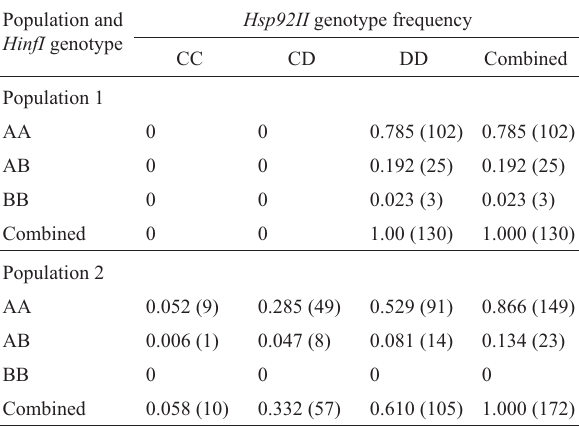
Table 1 - Genotypic frequency distributions for the MYF 5 gene HinfI and Hsp92II polymorphic loci haplotypes for two pig populations. The num- berofpigswithrecordsforeachgenotypefrequencyisshowninparenthe- ses. Population 1 (n = 130), composed of 28 Yorkshire, 46 Landrace, 21 Yorkshire¡ x Landrace and 35 Landrace x Yorkshire pigs; and population 2 (n = 172), consisting of 50 Meishan, 78 Yorkshire x Meishan and 44 Meishan x Yorkshire